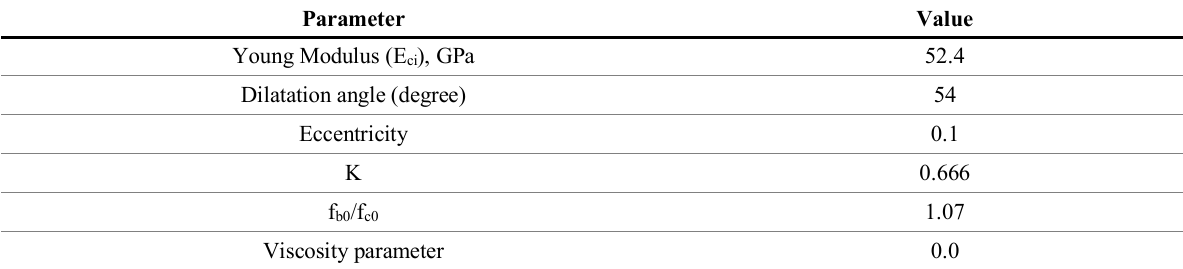
Table 2. Plasticity and Elasticity parameters